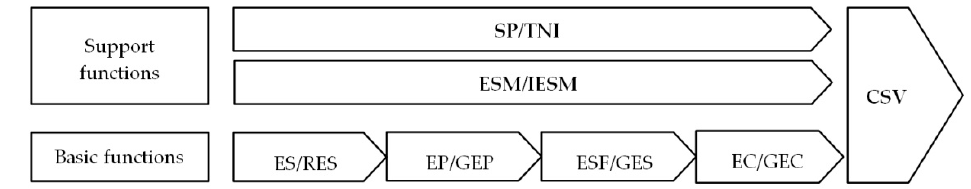
Figure 1. PES business model. Source: own study.